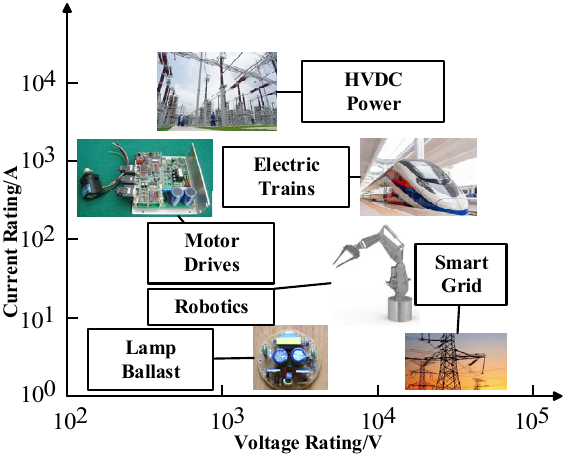
Figure 1. The wide spectrum of IGBT applications.